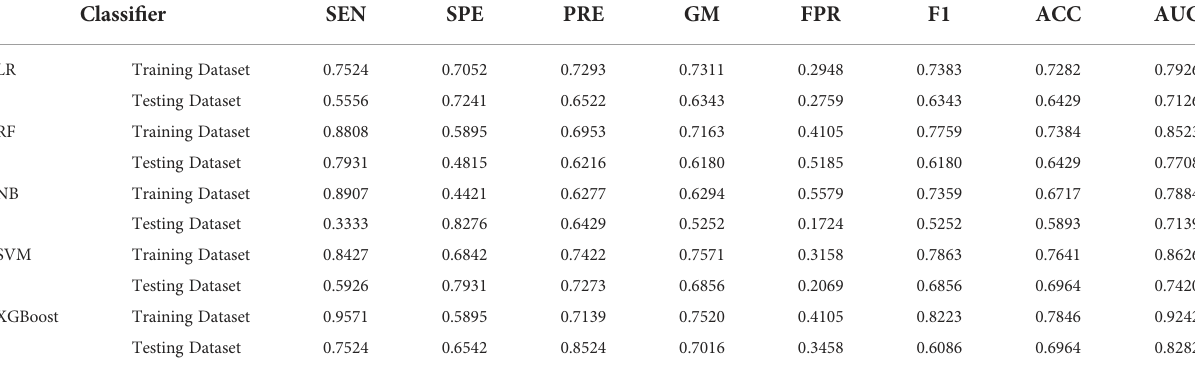
TABLE 2 Evaluation indicators of predictive performance of fi ve models in Luminal group and Non-luminal group. Classi fi